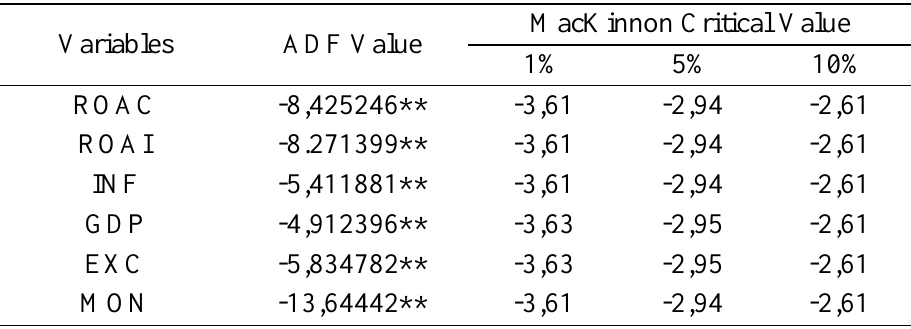
Table 3. Second Difference (2) Test with ADF